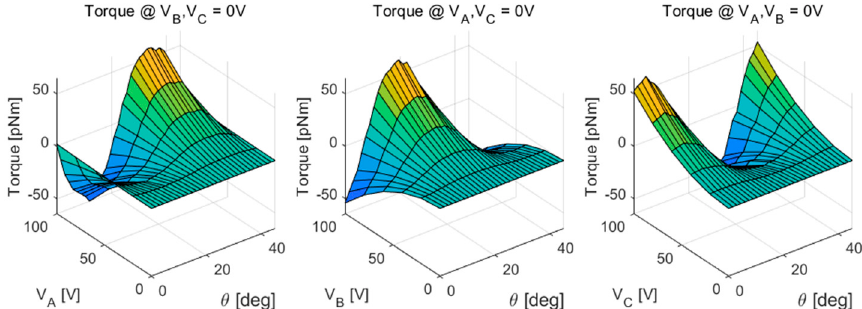
Figure 9. The torque model.